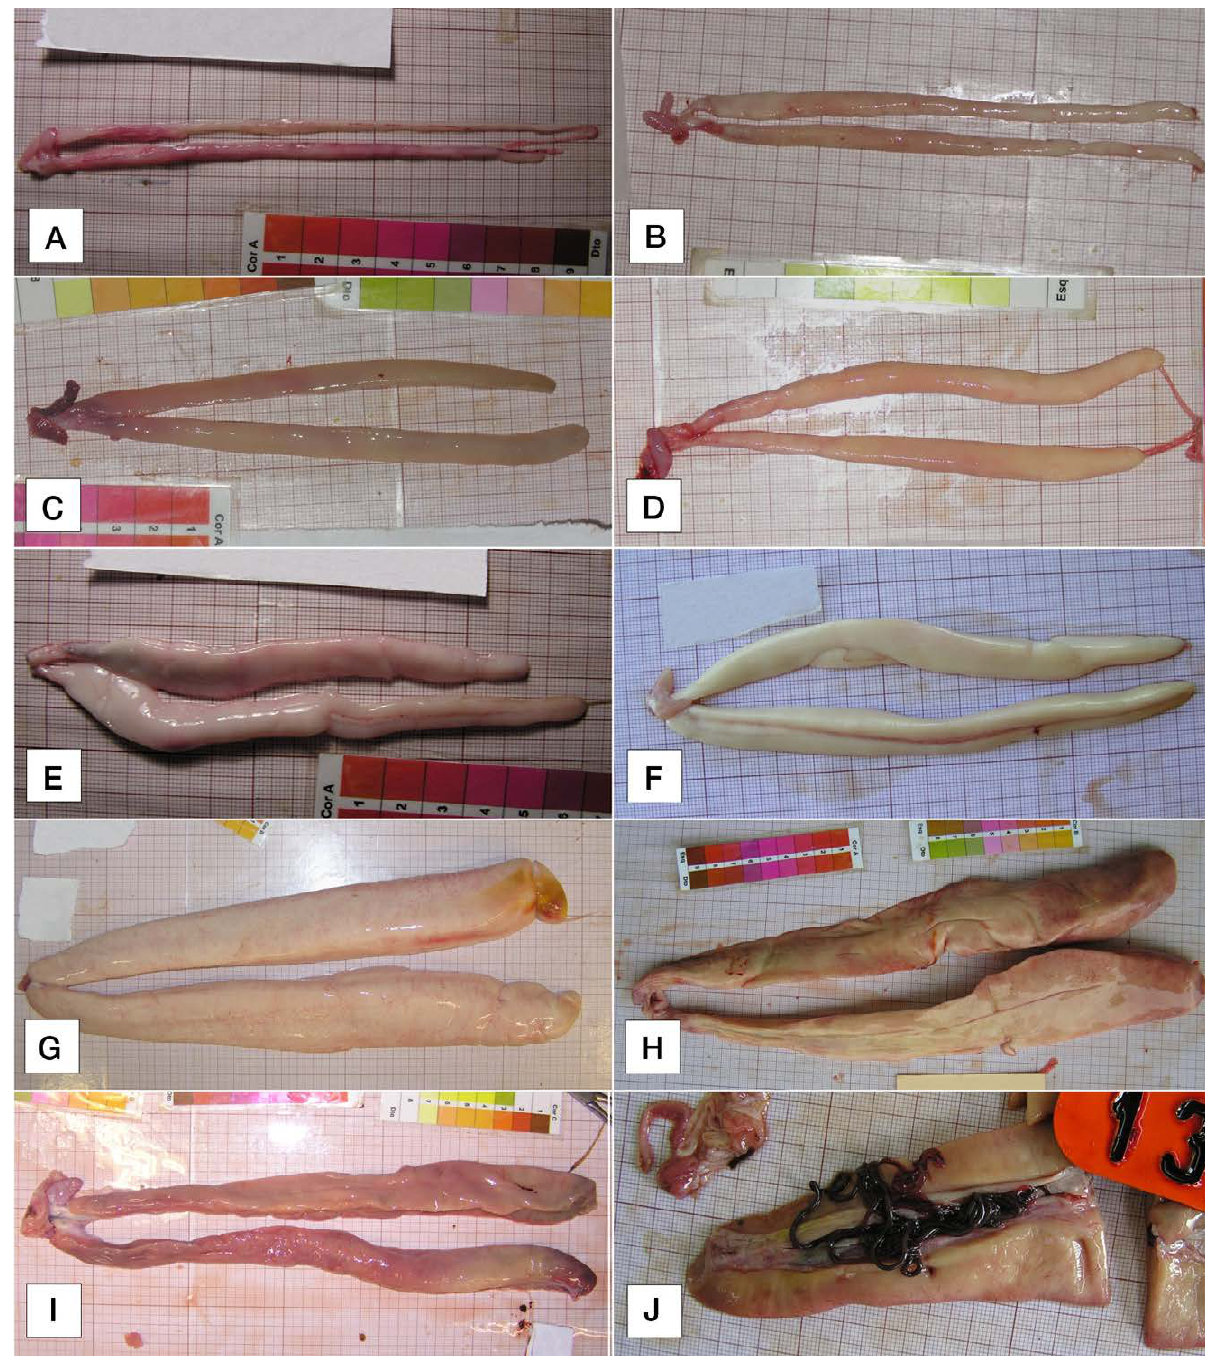
Fig. 3. – Macroscopic appearance of meagre male gonads [TL, total length in cm; M, month of capture; P, Place of capture, Southern Coast (SC) or Tagus Estuary (TE); H, Histological stage]. A, anatomical class I [TL, 66; M, May; P, SC; H, developing]; B, anatomical class I [TL, 59; M, June; P, TE; H, spawning capable (virgin)]; C, anatomical class II [TL, 76; M, July; P, TE; H, developing]; D, anatomical class II [TL, 69; M, June; P, TE; H, spawning capable (virgin)]; E, anatomical class II [TL, 59; M, May; P, SC; H, spawning capable (mature)]; F, anatomical class III [TL, 59; M, June; P, TE; H, spawning capable (virgin)]; G, anatomical class III [TL, 100; M, May; P, TE; H, spawning capable (mature)]; H, anatomical class IV [TL, 148; M, June; P, SC; H, regressing]; I, anatomical class IV [TL, 144; M, October; P, SC; H, regenerating]; J, close-up of live parasites from genus Philometra